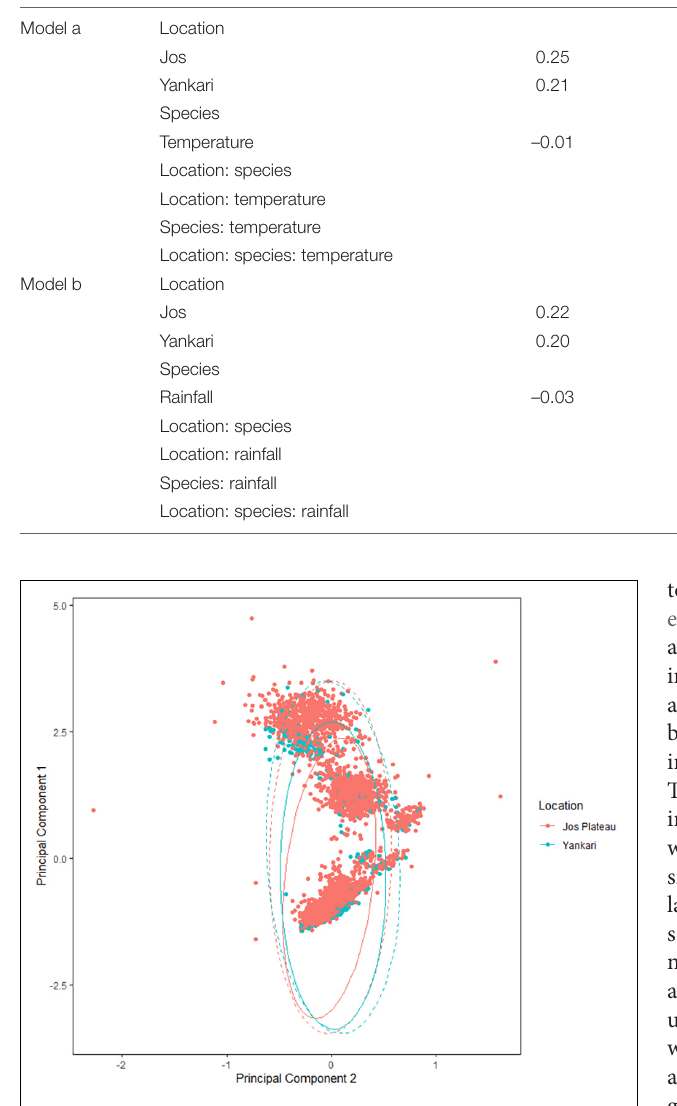
FIGURE 3 | Plots of principal component 1 vs. principal component 2 of lowland and montane species of northern savanna region of